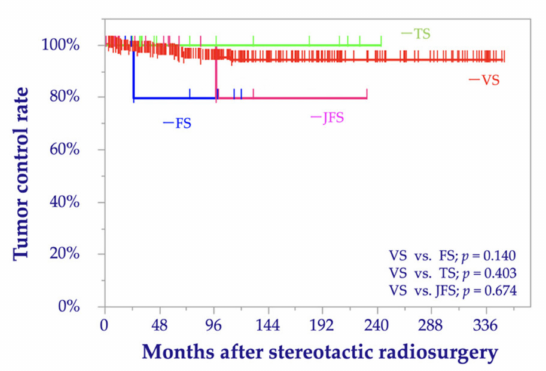
Figure 1. Kaplan–Meier curves of the tumor control rates before matching comparing trigeminal schwannoma (TS), facial schwannoma (FS), jugular foramen schwannoma (JFS), and vestibular schwannoma (VS).